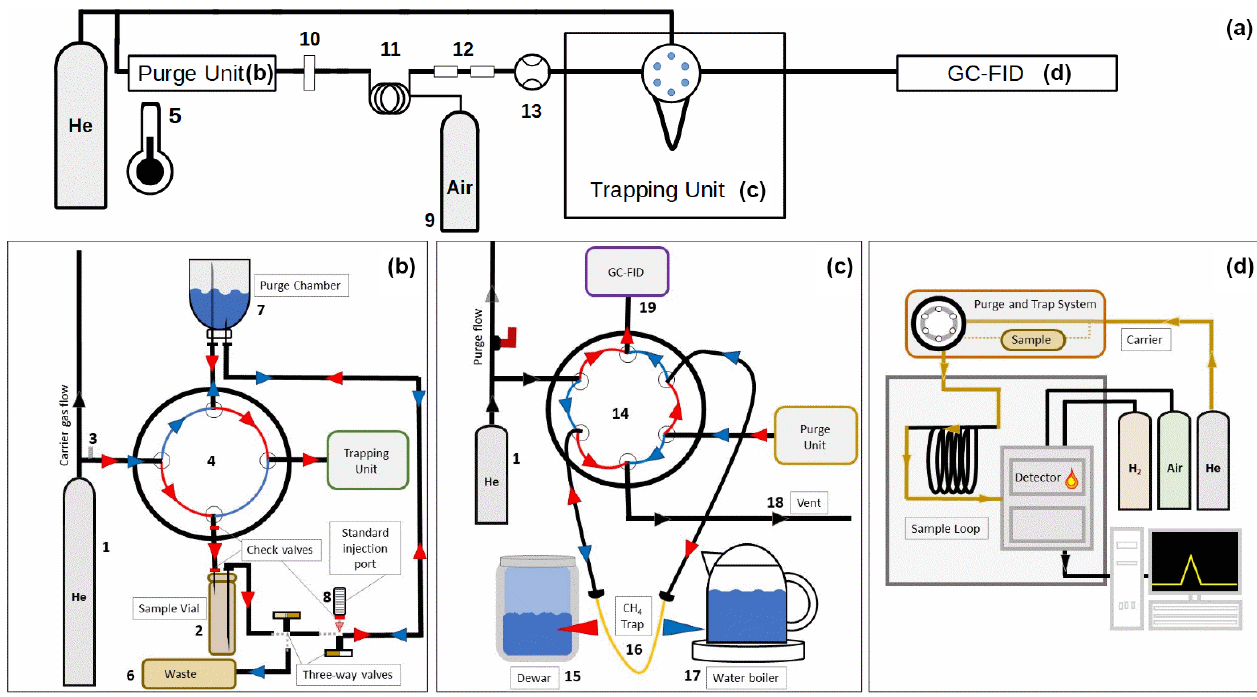
Figure 2. Schematic illustration of the PT system set-up: (a) general set-up of the PT system, the components of the purge unit, the trapping unit, and the GC-FID are shown in detail in (a) – (c) ; (b) set-up of the purge unit showing the direction of the He gas stream when samples are purged (red) and when the purge chamber is emptied (blue); (c) set-up of the trapping unit showing the direction of the He gas stream when the gas is trapped (red) and desorbed (blue); (d) set-up of the GC-FID system. The individual components of the PT system are (1) He gas cylinder with pressure regulator, (2) sample vial, (3) needle valve, (4) four-port valve, (5) thermometer, (6) double-walled wastewater pipe and wastewater canister, (7) purge chamber, (8) Luer-Lock injection port with check valve and Safeflow ® infusion valve, (9) compressed air cylinder with pressure regulator, (10) filter, (11) Nafion ® counterflow drying tube, (12) two glass dry traps filled with P 2 O 5 , (13) flowmeter, (14) VICI Valco ® six-port valve, (15) Dewar tank filled with liquid nitrogen, (16) CH 4 trap filled with molecular sieve (5Å), (17) water boiler, (18) vent, and (19) connection to